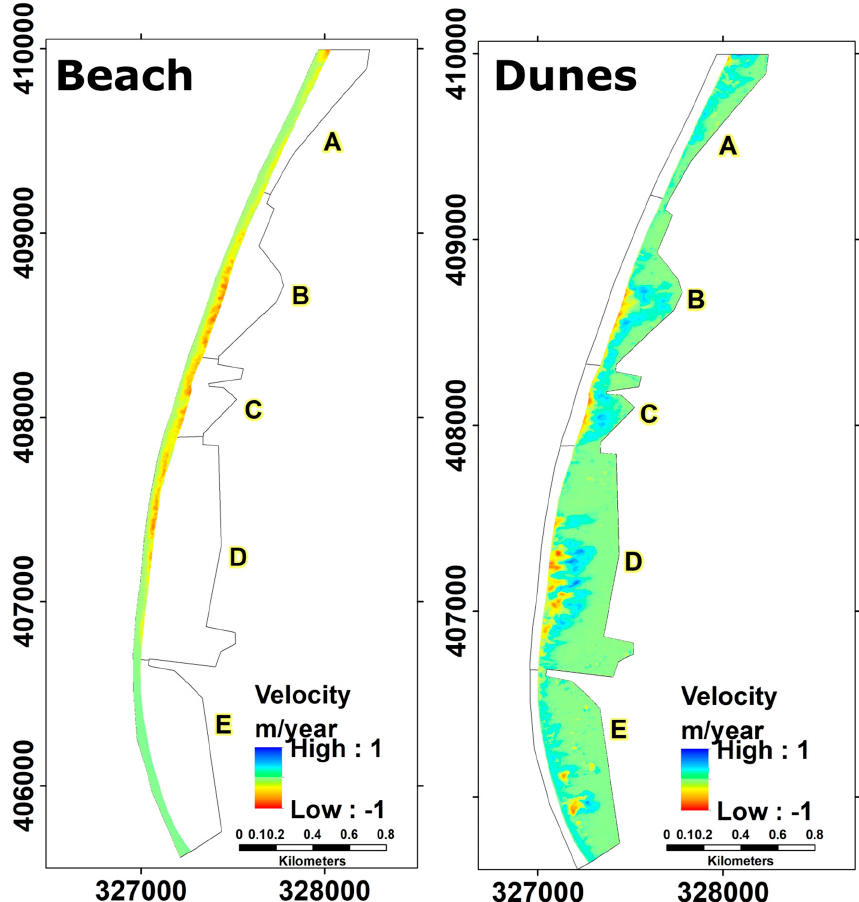
Figure 4. The rate of elevation change in the beach and dune areas. Blue colours represent the rate of elevation increase while red represent rates of elevation decrease, i.e., loss of material. Loss of material on the beach is balanced by an increase in inland dunes.